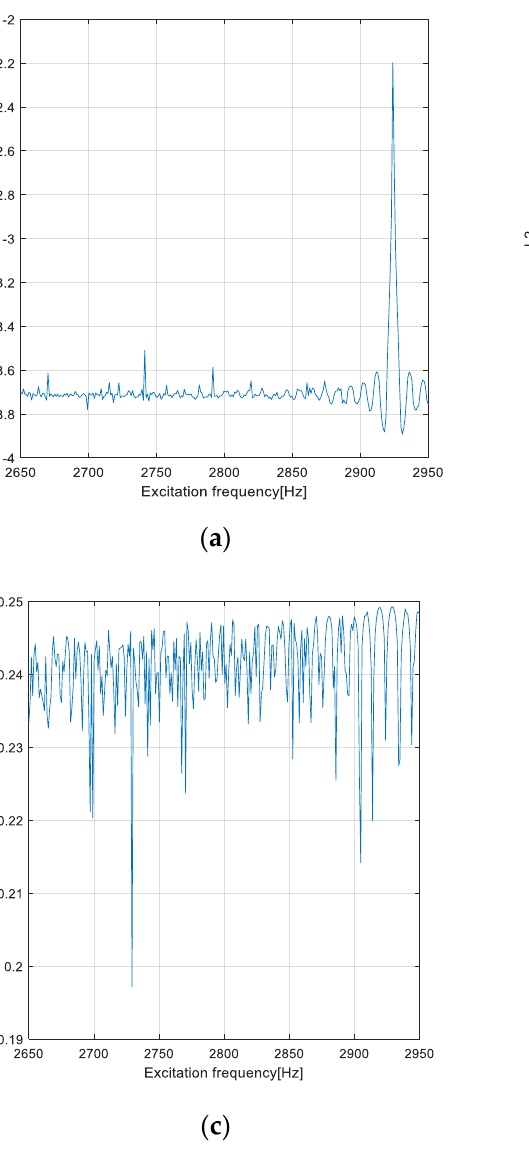
= 9 0 , ξ = 6.4 · 10 − 3 2